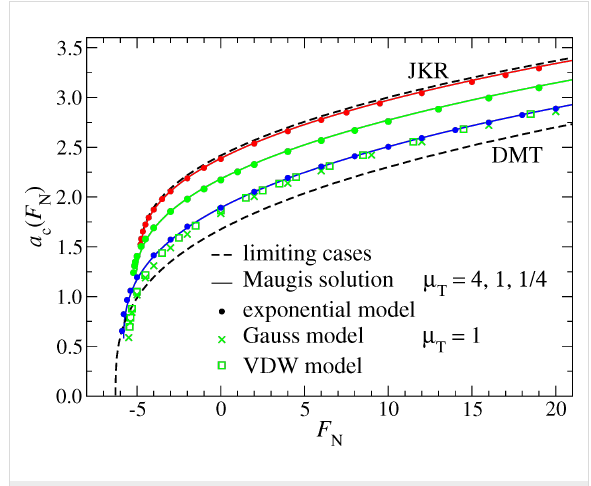
Figure 11: Contact radius a c as a function of load F N for the exponen- tial and the MD model using different Tabor coefficients, ranging from μ T → ∞ (JKR, top) to μ T = 0 (DMT, bottom). For the Gauss and VDW models, only μ T = 1 is shown. Their a c ( F N ) curve is similar to that of the Maugis and the exponential model for μ T = 1/4. Color coding: μ T = 4 (red), μ T = 1 (green), and μ T = 1/4